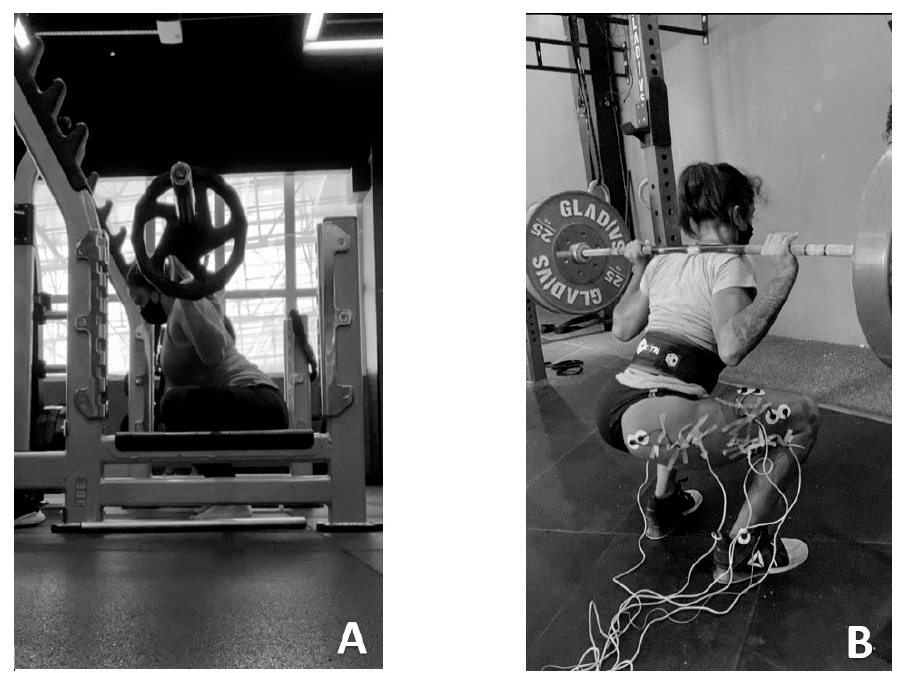
Figure 2. ( A ) Strength test (10 RM); ( B ) Electromyographic analysis during the squat.